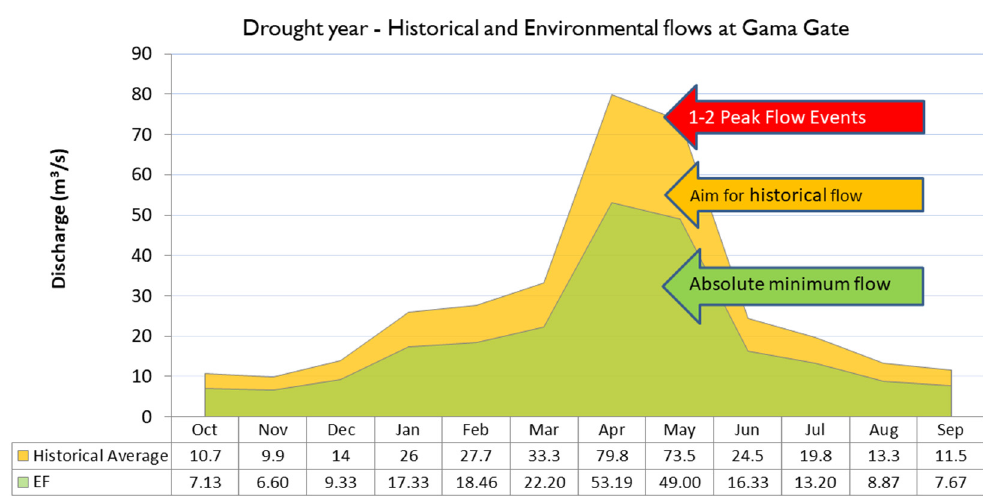
Figure 12. Minimum recommended freshwater flows (m 3 /s) at Gama Gate for below-normal (drought) rainfall years.